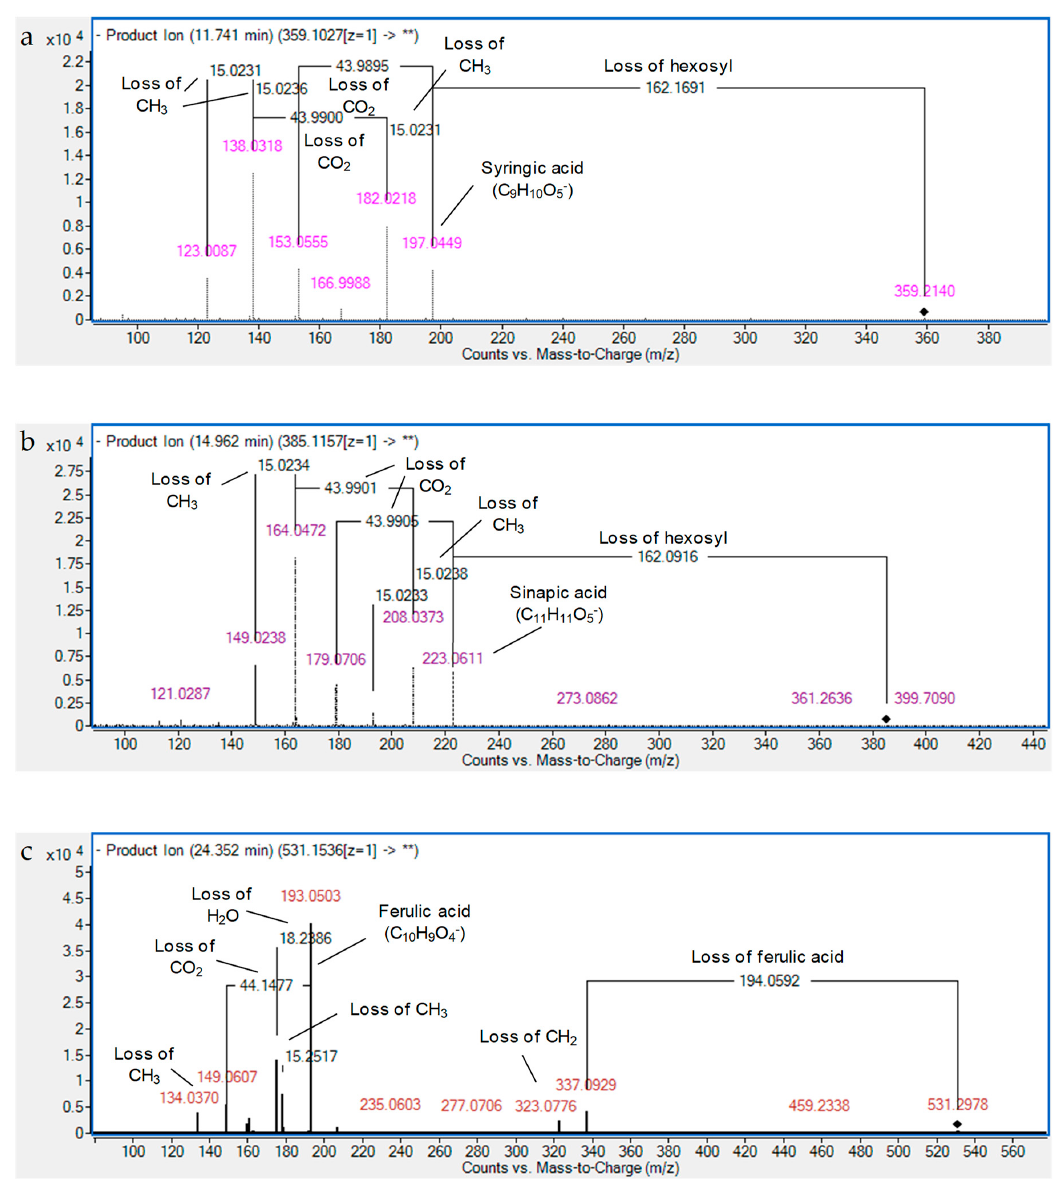
Figure 2. Fragmentation patterns of ( a ) syringic acid hexoside, ( b ) sinapic acid hexoside, and ( c ) diferuloyl hexoside.